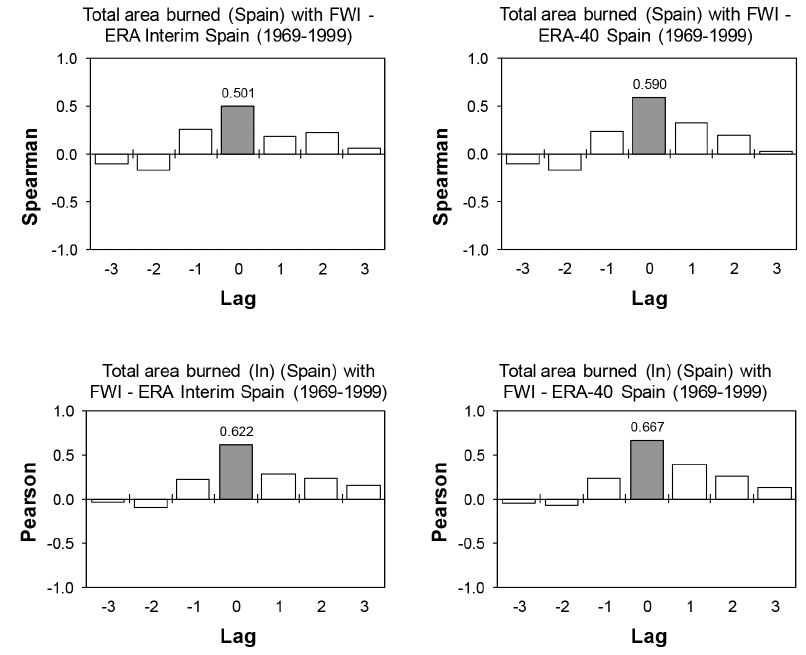
Figure 9. Cross-correlation graphs between total burned area (original and ln-transformed) at the national scale in Spain and FWI values es- timated from ERA-40 and ERA Interim Spain data for the period 1969–1999 (grey columns indicate significant values at the 95% confidence level).